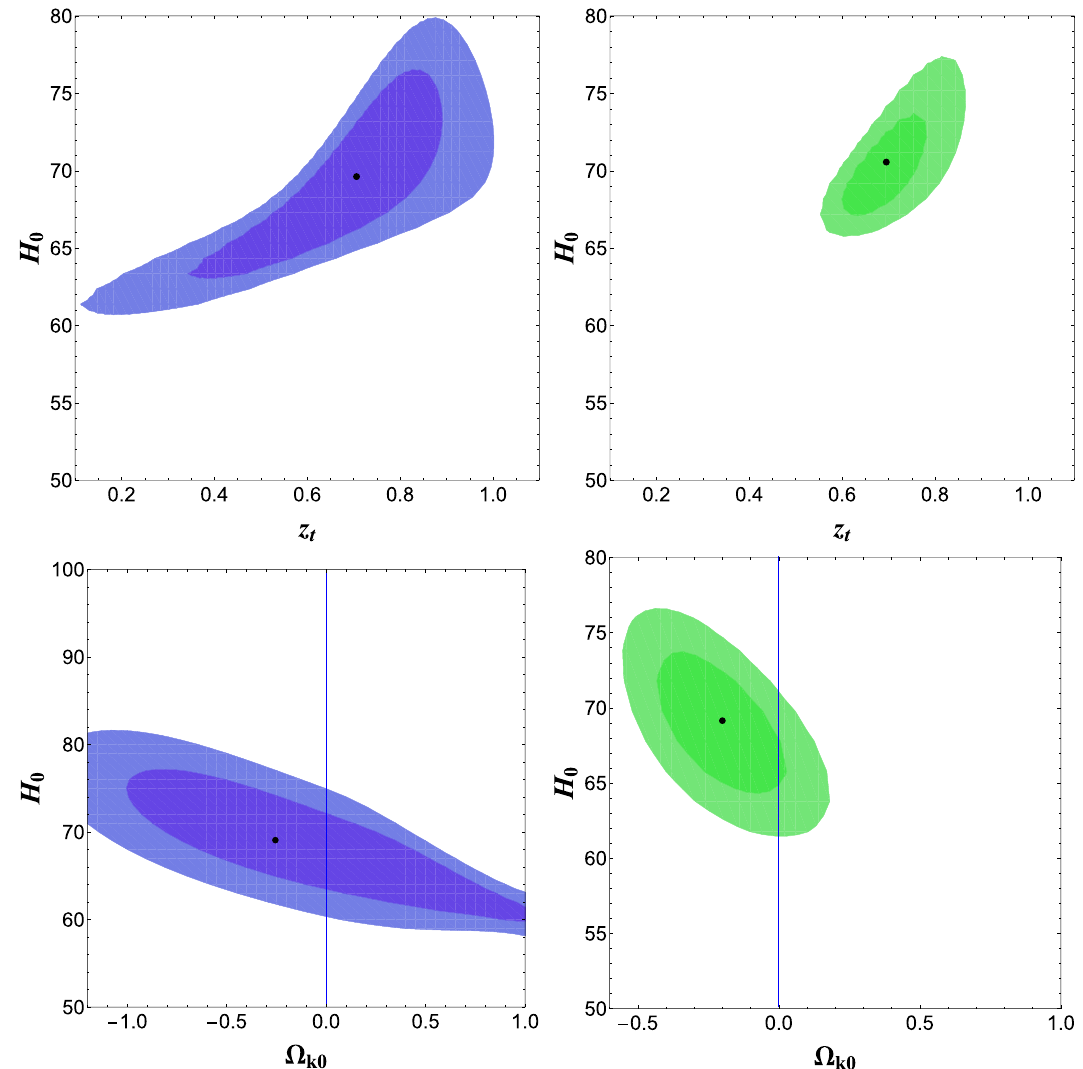
Fig. 4 In the figure on the left we show constraints on the Hubble constant using data from the Hubble parameter and on the left side we add data from Supernovas Ia. In all cases we marginalize the matter density parameter in the interval 0 . 07 < (cid:5) m 0 < 0 .